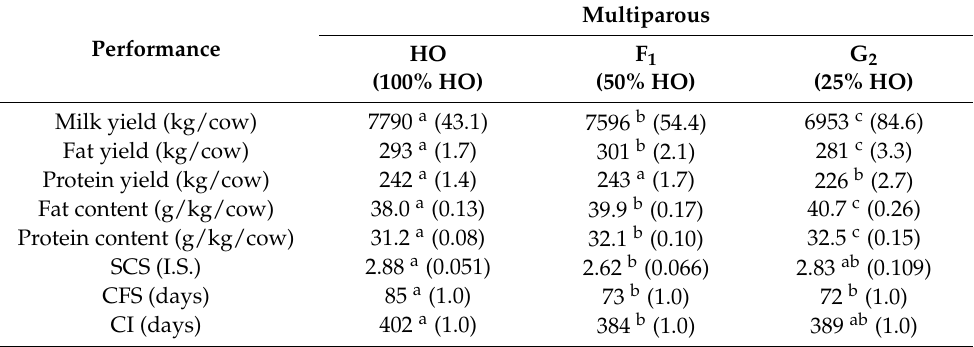
Table 6. Least square means estimates (standard error in parentheses) of 305-d milk, fat and protein yields, fat and protein contents, somatic cell score (SCS), calving to first service interval (CFS) and calving interval (CI) for multiparous cows of the three genetic classes: Holstein (HO), first-generation crossbreds with 50% of Holstein genes (F 1 ) and three-breed second-generation crossbreds with 25% of Holstein genes (G 2